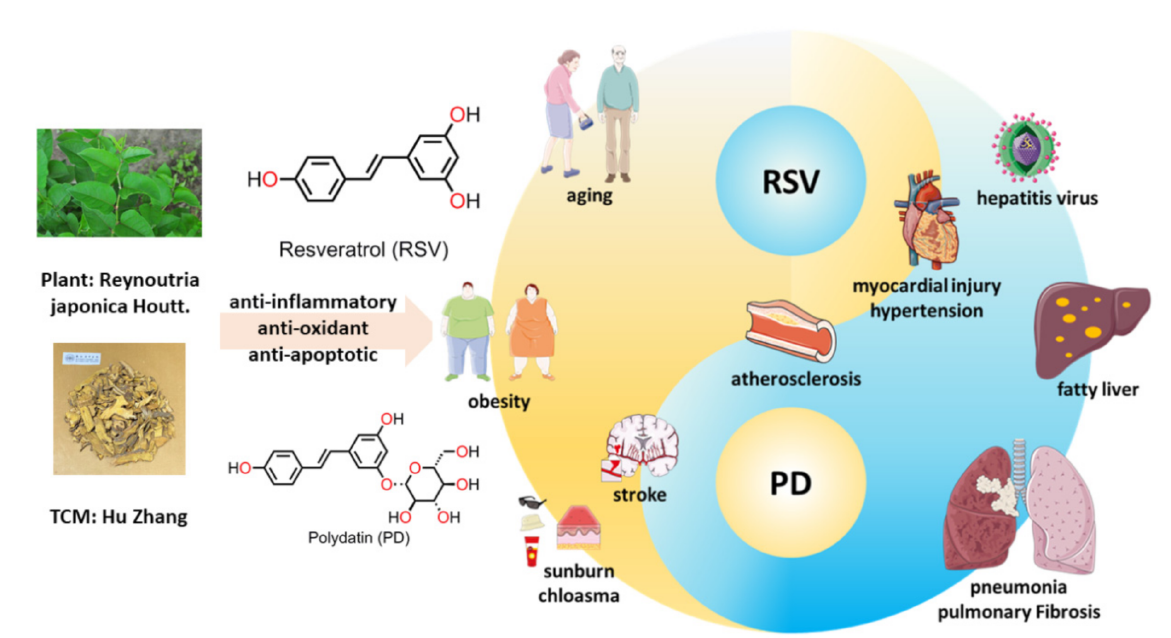
Figure 1. The structures of RSV and PD and their shared and separate clinical